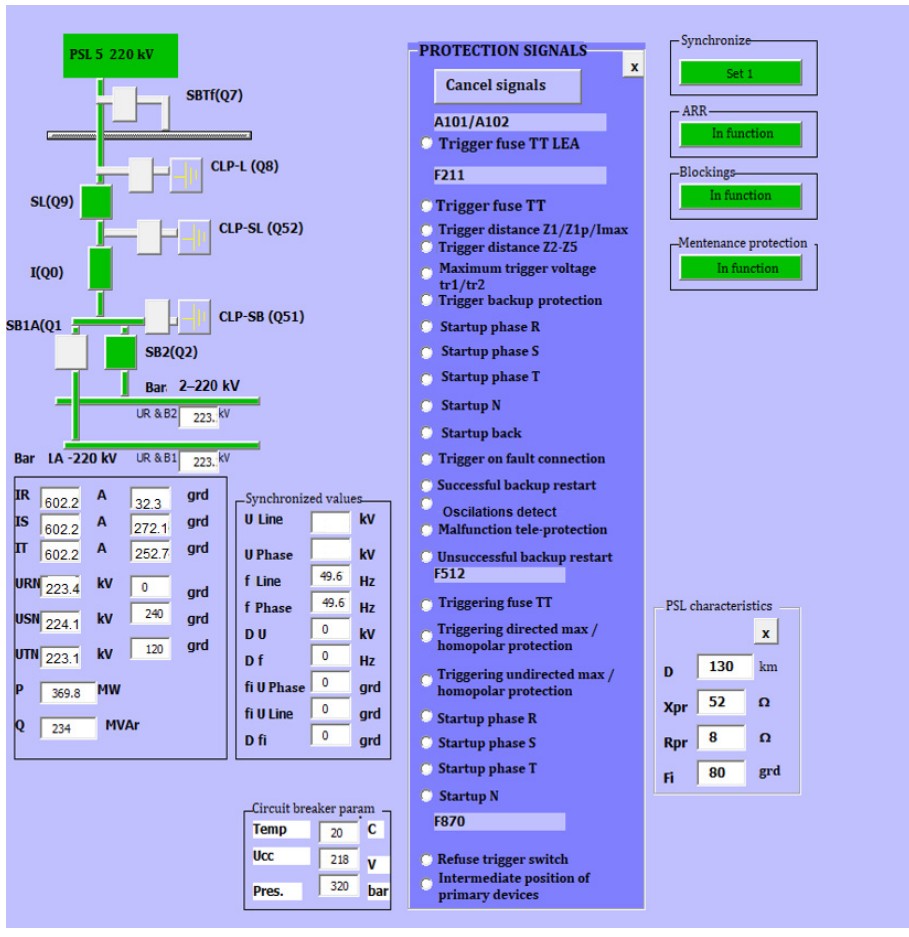
Figure 24. The control screen of a line cell.